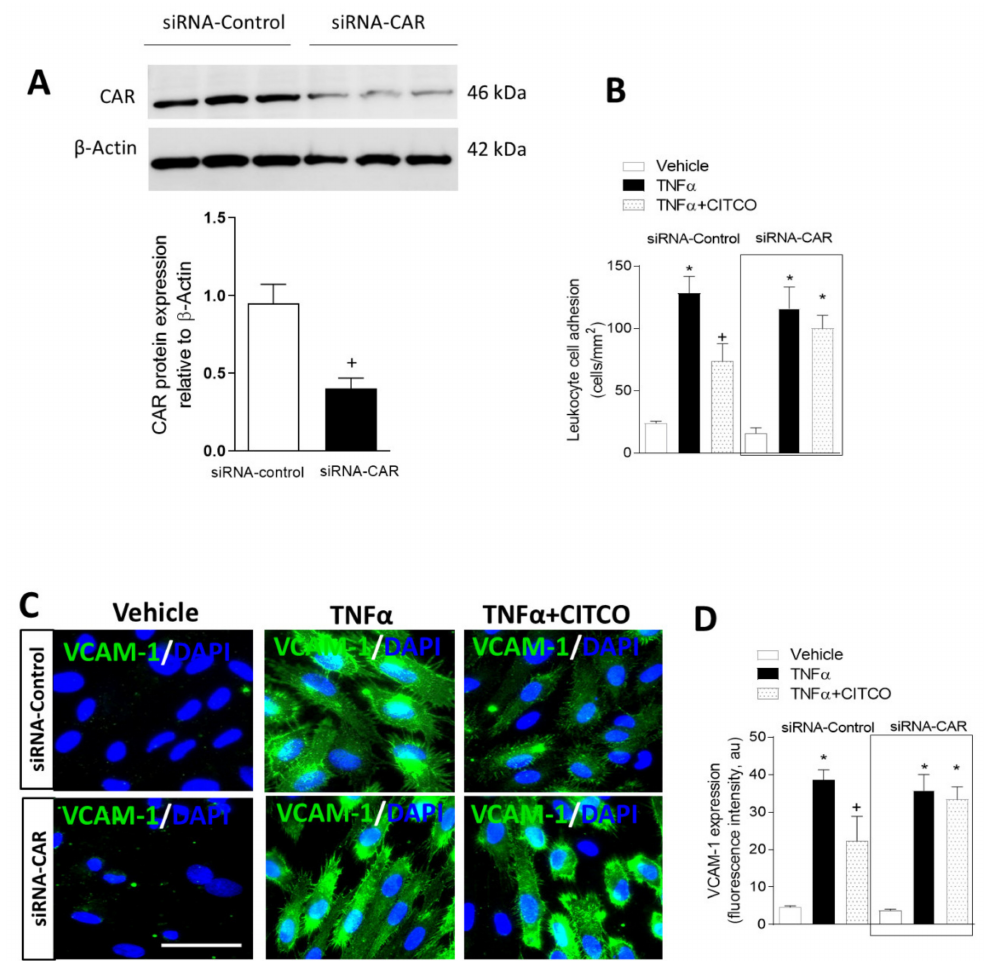
Figure 3. Knockdown of CAR by siRNA blocks the suppressive effect of CITCO on TNF α -induced leukocyte–endothelial interactions and VCAM-1 expression. Endothelial cells were transfected with control or CAR-specific siRNA. At 48 h post-transfection, cells were pretreated with CITCO (3 µ M) for 24 h and then stimulated with TNF α (20 ng/mL, 24 h). ( A ) CAR protein expression in transfected HUVEC was analyzed by Western blot. Protein quantification was performed by densitometry and CAR protein levels were normalized to β -actin. Values are expressed as mean ± SEM ( n = 6). + p < 0.05 relative to control siRNA transfected cells. ( B ) After transfection HUVEC were treated with vehicle (0.1% DMSO) or CITCO (3 µ M) for 24h and then stimulated with TNF α (20 ng/mL, 24h). Next, whole blood from healthy volunteers was perfused across the endothelial monolayers for 5 min at 0.5 dynes/cm 2 and leukocyte adhesion was quantified. Data are mean ± SEM ( n = 4 for each group). * p < 0.05 relative to the respective vehicle group, + p < 0.05 relative to the respective TNF α -stimulated cells. ( C ) Representative images showing VCAM-1 expression in transfected HUVEC. Immunoreactivity was visualized using an Alexa Fluor 488 secondary antibody (VCAM-1, green). Nuclei were counterstained with DAPI (blue). Scale bar = 50 µ m. ( D ) Fluorescence intensity of Alexa Fluor 488 (VCAM-1, green) was quantified using ImageJ. Values are expressed as mean ± SEM, n = 6. * p < 0.05 relative to the respective vehicle group, + p < 0.05 relative to the respective TNF α -stimulated